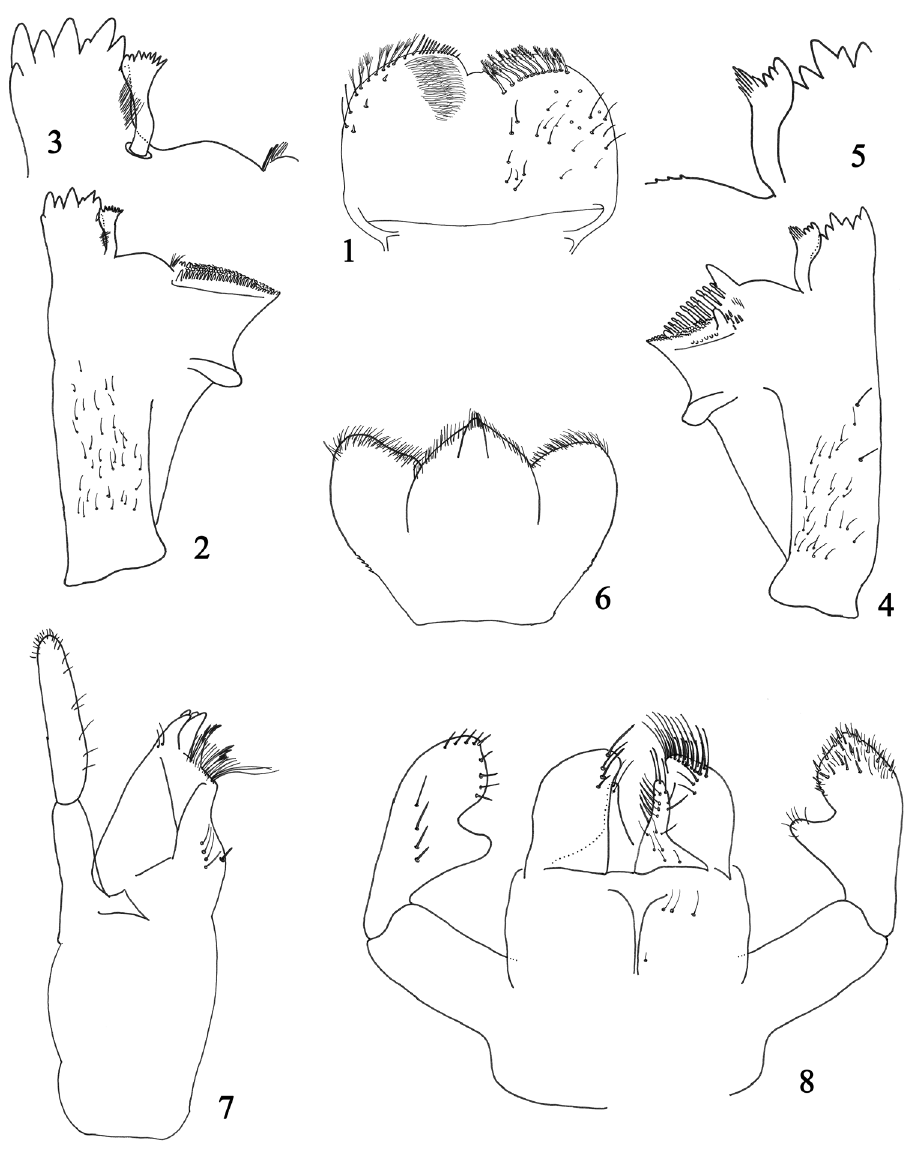
Figures 1–8. Larval structures of Labiobaetis potamoticus sp. n.: 1 labrum (left : ventral; right : dorsal) 2 right mandible 3 detail of right mandible: canines and prostheca 4 left mandible 5 detail of left mandi- ble: prostheca 6 hypopharynx 7 right maxilla 8 labium.